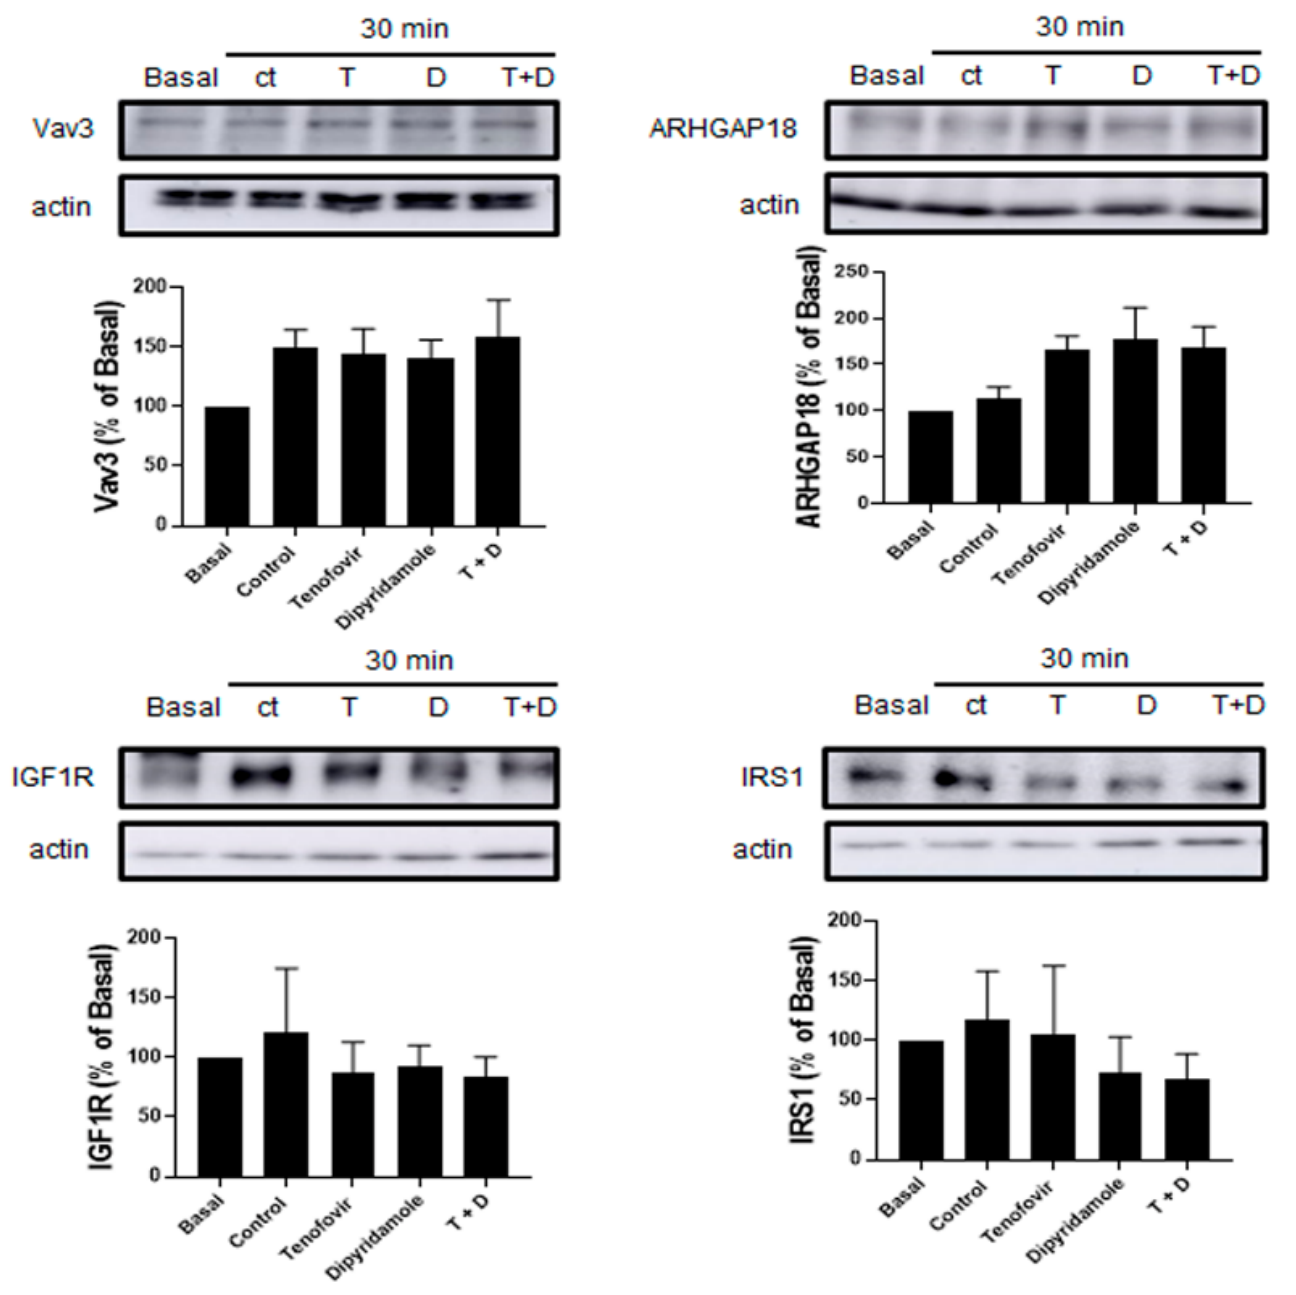
Figure 7. No significant changes in IGF1R activation in A2AKO mice. Vav3, ARHGAP18, IGF1R and IRS1 expression were studied in osteoblast precursors in the presence of tenofovir at 1 µ M alone or with dipyridamole at 1 µ M. To normalize for protein; the membranes were reprobed with actin.